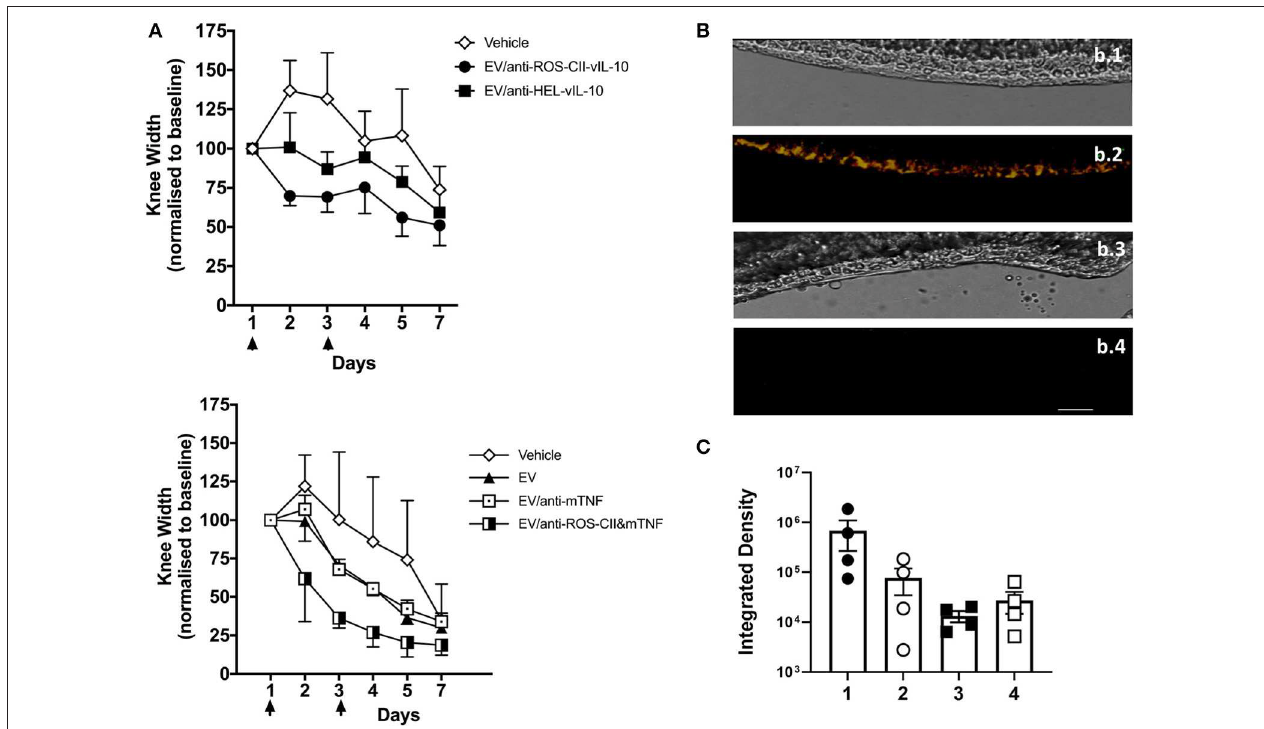
FIGURE 4 | Treatment of antigen-induced arthritis with EV enriched with monotherapy. Antigen-induced arthritis was induced in the right knee of female C57BL/6 mice. On day 1 and 3, mice were injected with 6 × 10 5 i.v. of EV, EV/anti-ROS-CII-vIL-10, EV/anti-HEL-vIL-10, EV/anti-mTNF, EV/anti-ROS-CII&mTNF, or PBS vehicle control. (A) Treatment points are indicated by black arrows. Knee swelling was quantified daily using digital calipers. Data are expressed as mean ± SEM, n = 5–8 mice per treatment group and n = 3–6 mice for vehicle group. Top panel were analyzed by two-way repeated-measures ANOVA (with time and treatment as independent variables) with Holm–Sidak post-hoc tests. As the data were all normalized to day 1, day 1 was omitted from the analysis (as the values are all 100). A significant difference between vehicle and EV/anti-ROS-CII-vIL-10 ( p = 0.028) was observed. Lower panels show analysis by a mixed-model ANOVA, allowing for a random intercept and slope of day (which was entered as a continuous variable), with treatment as a fixed factor. There were no significant differences between the vehicle group and the EV alone ( p = 0.216) or EV/anti-TNF ( p = 0.216). A significant difference between vehicle and EV/anti-ROS&mTNF ( p = 0.013) was observed. (B) Knees from EV/anti-ROS-CII-vIL10- and EV/anti-HEL-vIL-10-treated mice were sectioned and imaged by confocal microscopy to identify EV/antibody localization; bright-field images were also taken for reference (b.1, b.3). EV/anti-ROS-CII-vIL10 AIA knee (b.1, b.2); EV/anti-HEL-vIL-10 AIA knee (b.3, b.4). Red